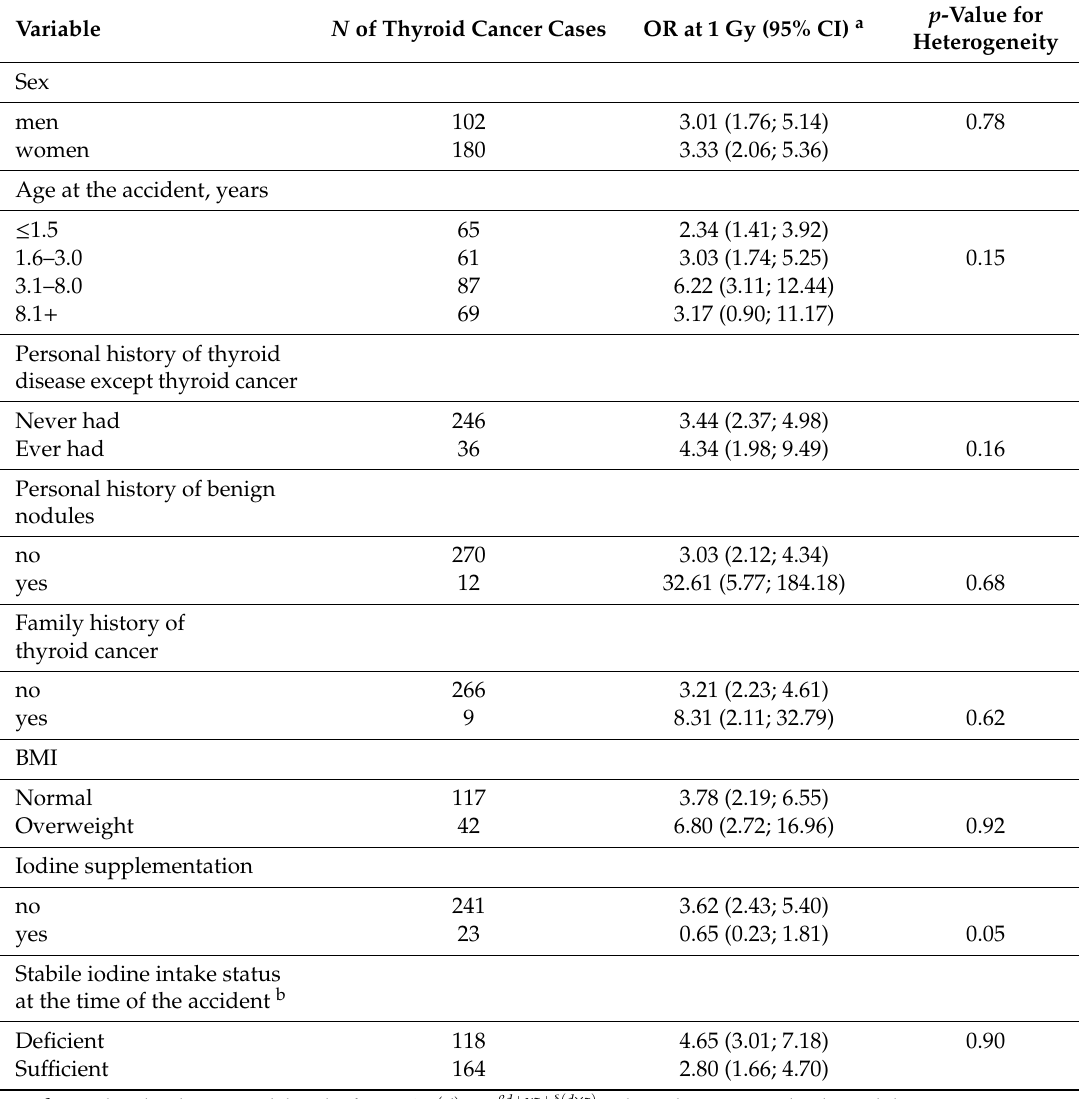
Table 5. Thyroid cancer odds ratios (OR) at 1 Gy and 95% confidence interval (95% CI) by categories